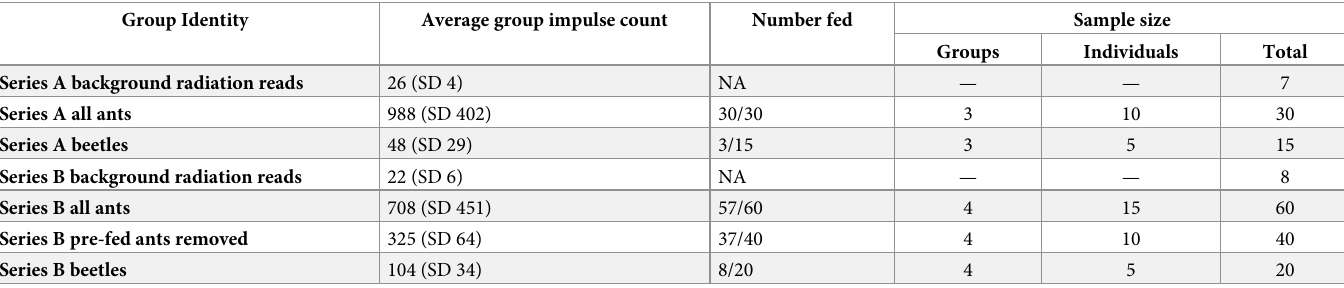
Table 2. Feeding experiment design and